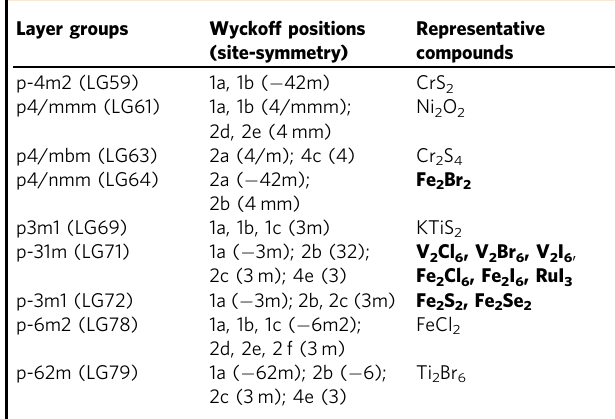
Fig. 2 Design procedure of the 2D materials with enhanced SOC effect. First, the elements of the 3 d /4 d series were chosen as 3 d : Sc~Ni and 4 d : Y~Rh, leading to 859 entries in C2DB. Second, the 3 d /4 d transition-metal ions need to reside at the Wyckoff positions whose site symmetries permit the existence of orbital multiplets. For instance, in a 2D Ni 2 O 2 with layer group p4/mmm (LG 61), the Ni ion occupying 1a Wyckoff position Ni@1a (site point group 4/mmm) permits orbital doublet, whereas that in Ni 2 S 2 Ni@2c (site point group mmm) does not. This fi lter obtains 542 entries remaining. Third, the considered orbital multiplets are partially occupied within 1.0 eV around the Fermi level, leading to 71 material candidates as the “ best of class ” . Table 1 Abstract of the 71 2D material candidates with 3 d / 4 d elements at selected Wyckoff positions with enhanced SOC effect.